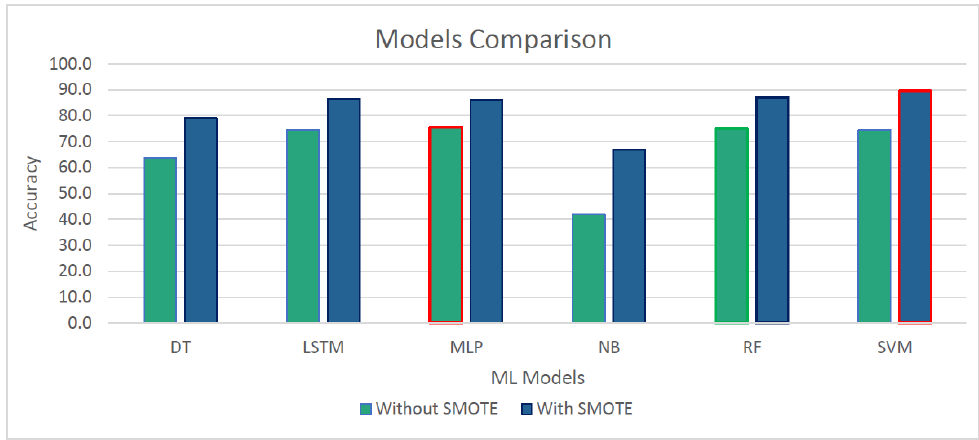
Figure 10. Exp1 Models